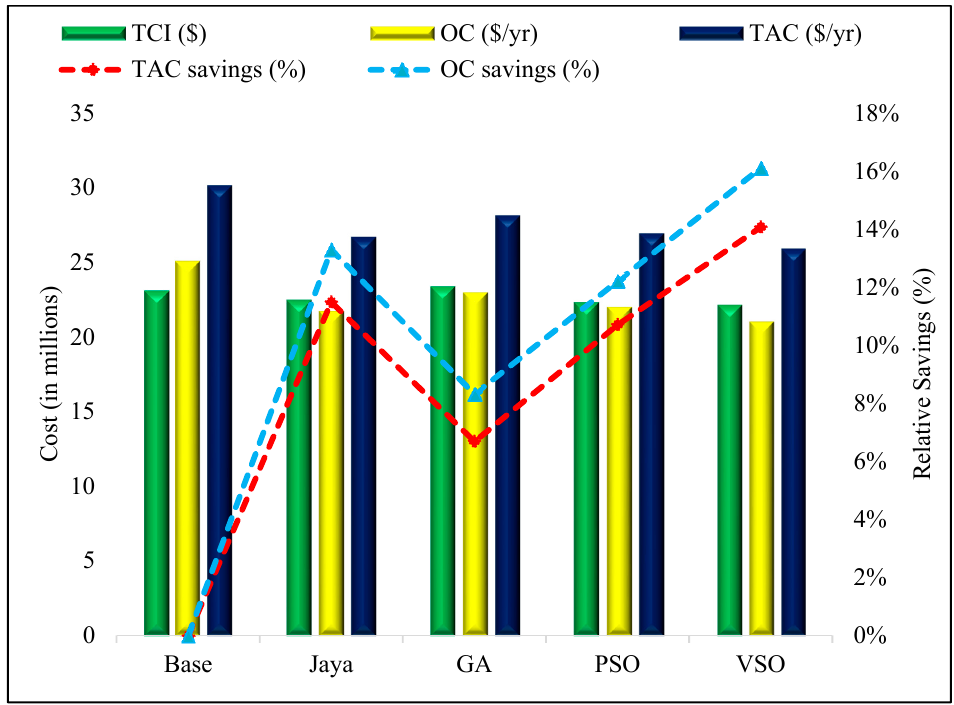
Figure 14. Economic analysis comparison for SMR processes using Jaya, Genetic Algorithm (GA), Particle Swarm Optimization (PSO), and vortex search optimization (VSO) approaches.